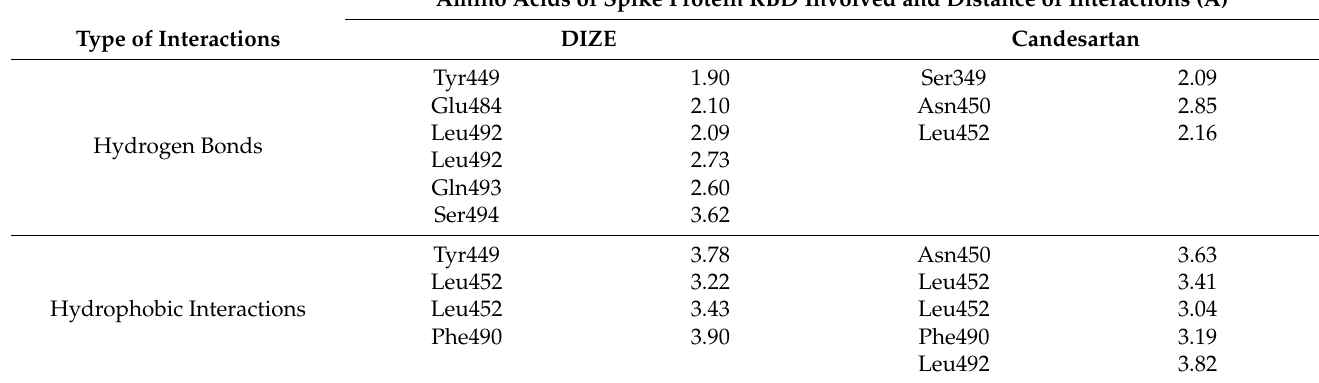
Table 4. Interactions of amino acid residues of the spike protein receptor-binding domain of SARS- CoV-2 (PDB ID: 7DDN) at the open state with DIZE and candesartan using PLIP. Amino Acids of Spike Protein RBD Involved and Distance of Interactions (Å) Type of Interactions DIZE Candesartan